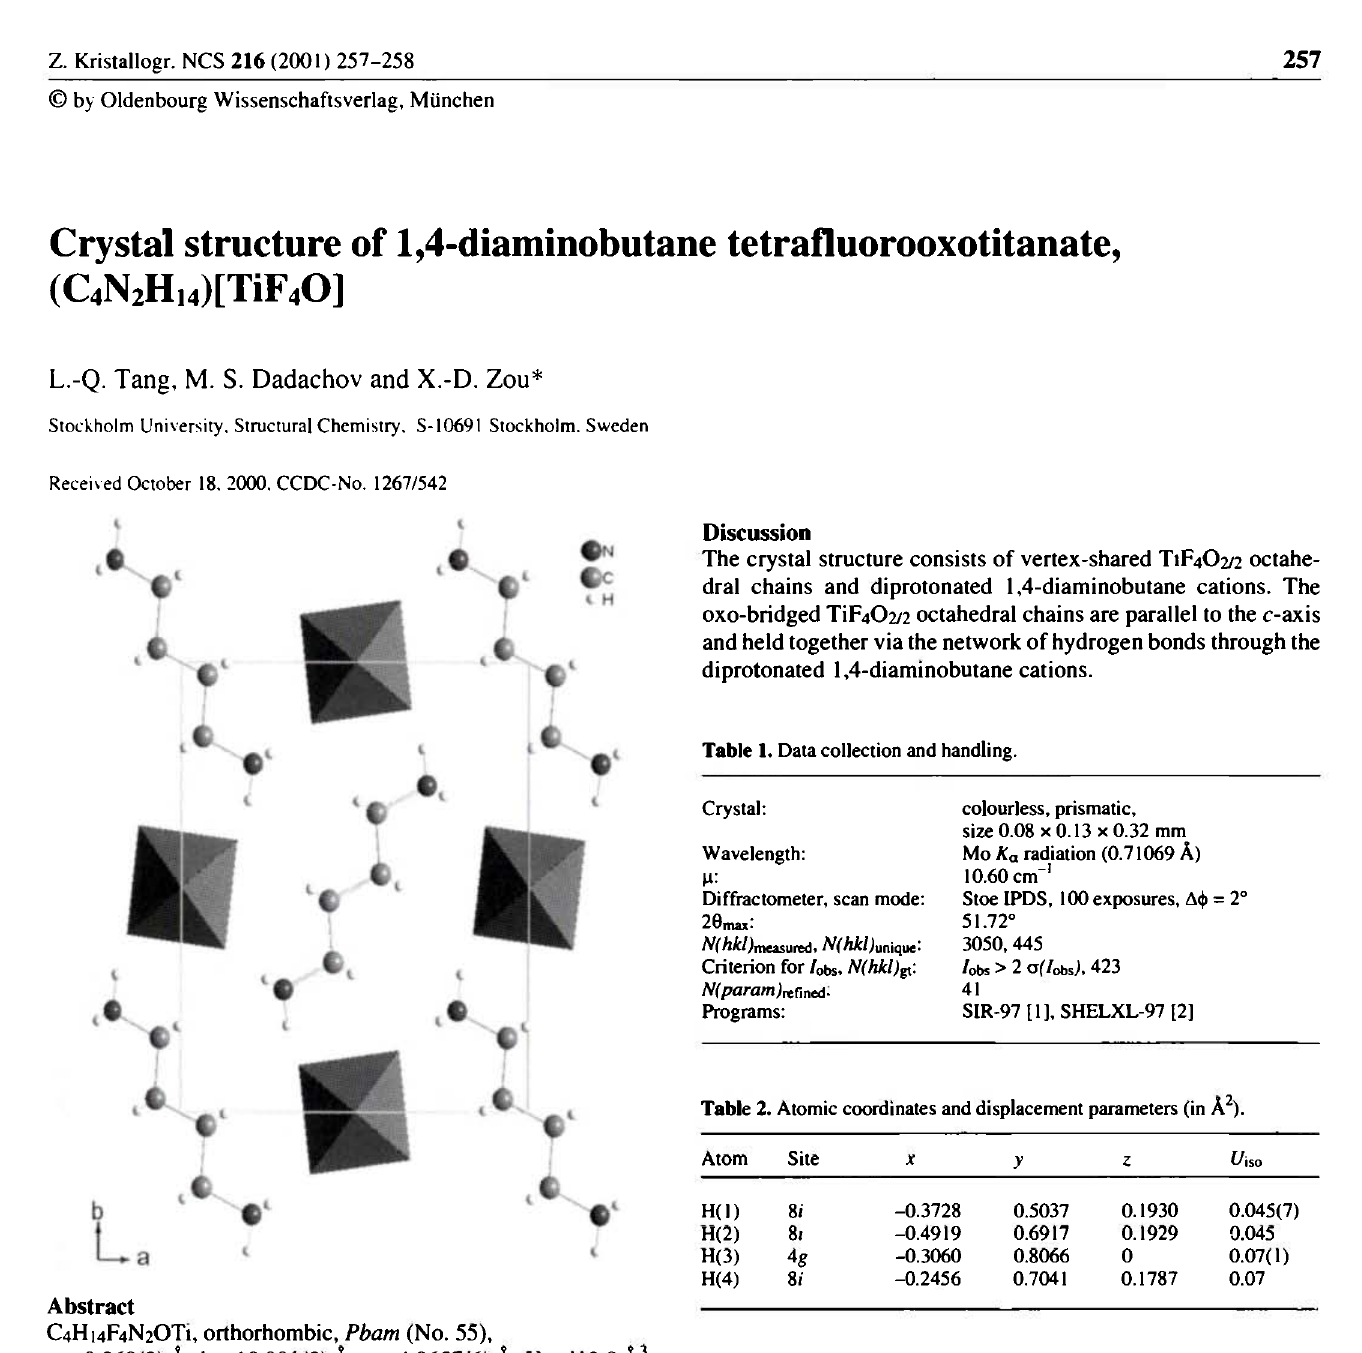
Table 2. Atomic coordinates and displacement parameters (in A 2